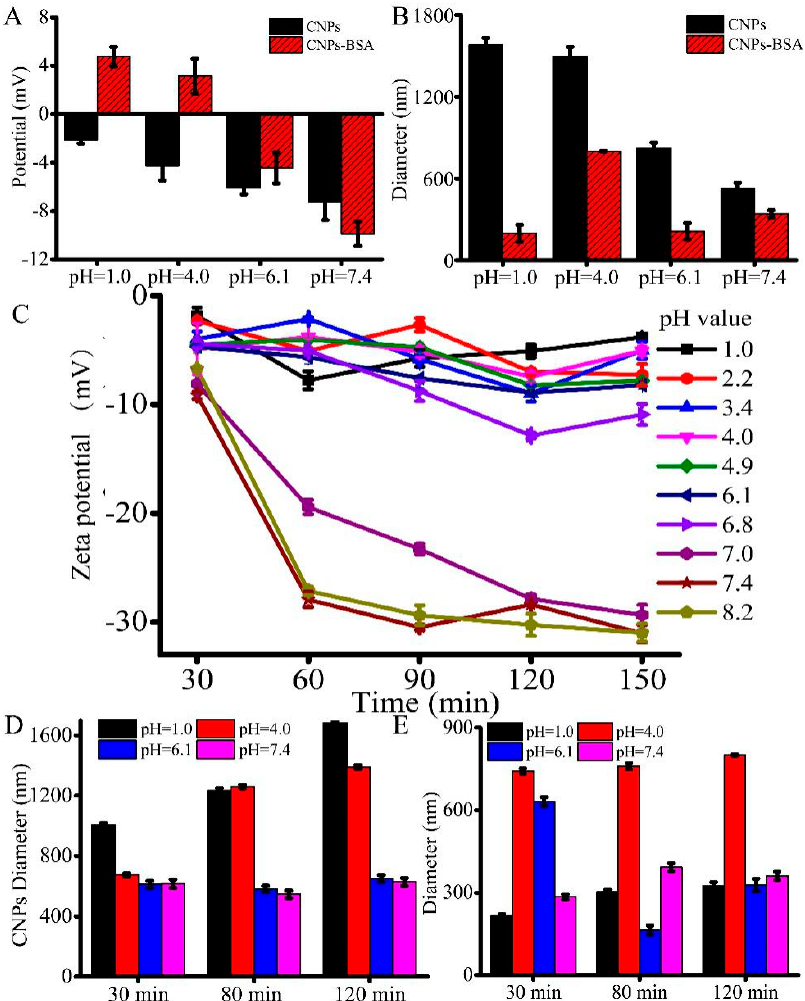
Figure 3. Effect of pH on the particle diameter as well as zeta potential of CNPs: ( A ) pH effect on the potential of the CNPs; ( B ) pH effect on the diameters of the CNPs. ( C ) Time-dependent zeta potential of CNPs by incubation at different pH values. ( D ) Time-dependent diameter changes of the CNPs by incubation at different pH values. ( E ) Time-dependent diameter changes of the CNP- BSA solution by incubation at different pH values.